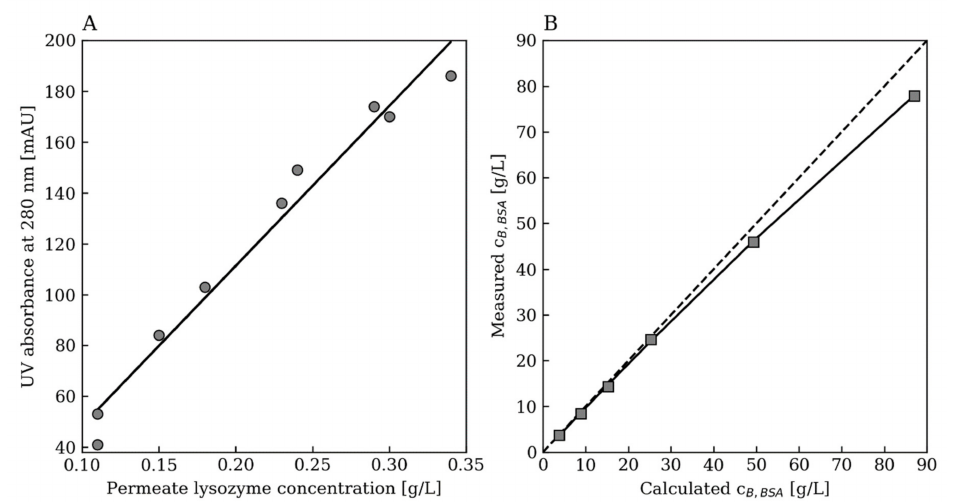
Figure A3. ( A ) Calibration of UV absorbance at 280 nm on the permeate side of the membrane versus c P,Lys of the lysozyme training set measured with HP-SEC (R 2 = 0.97). ( B ) Deviations between calculated and measured c B,BSA with an R 2 of 0.9997, including the identity line (dotted line). The concentration steps were performed at TMP 1.8 bar and CF 200 mL /